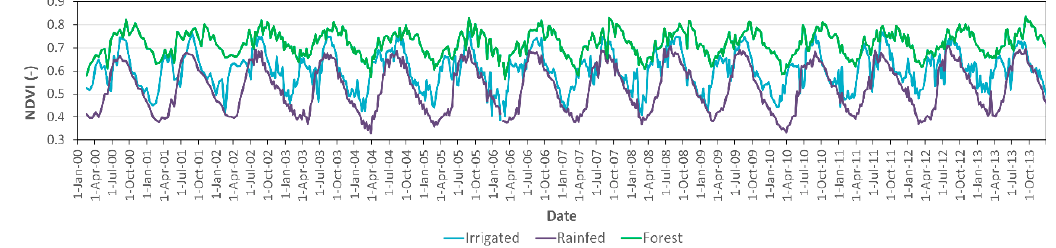
Figure 2. Normalized Difference Vegetation Index (NDVI time series of three main Land Use / Land Cover (LULC) classes in 2000–2014 based on the 250 meter MODIS NDVI products MOD13Q2 and